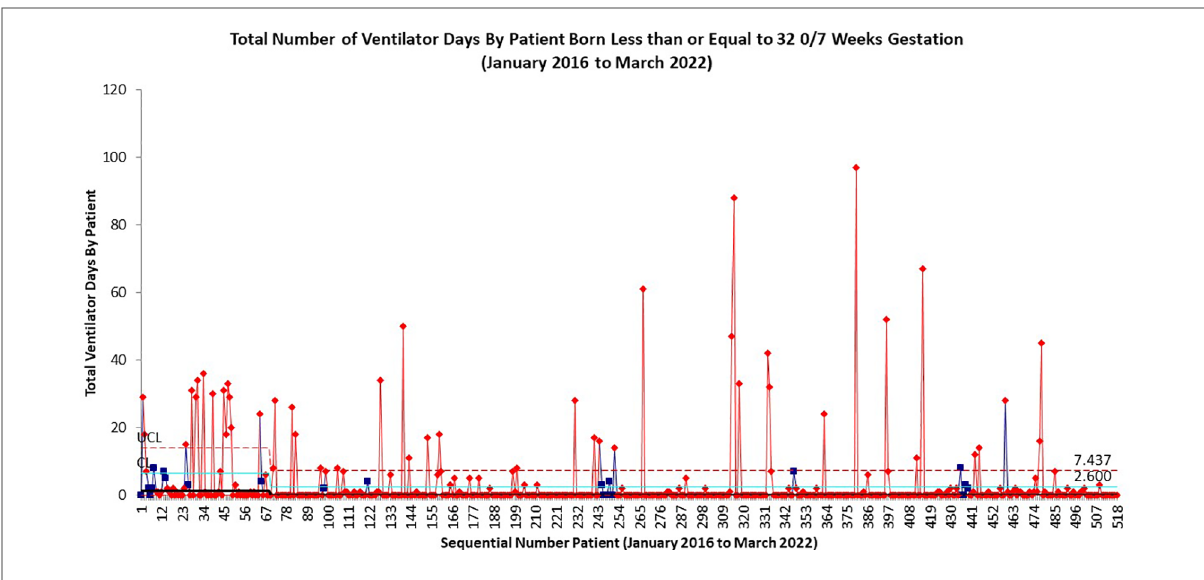
FIGURE 6 Ventilator days for infants born less than or equal to 32 0/7 weeks